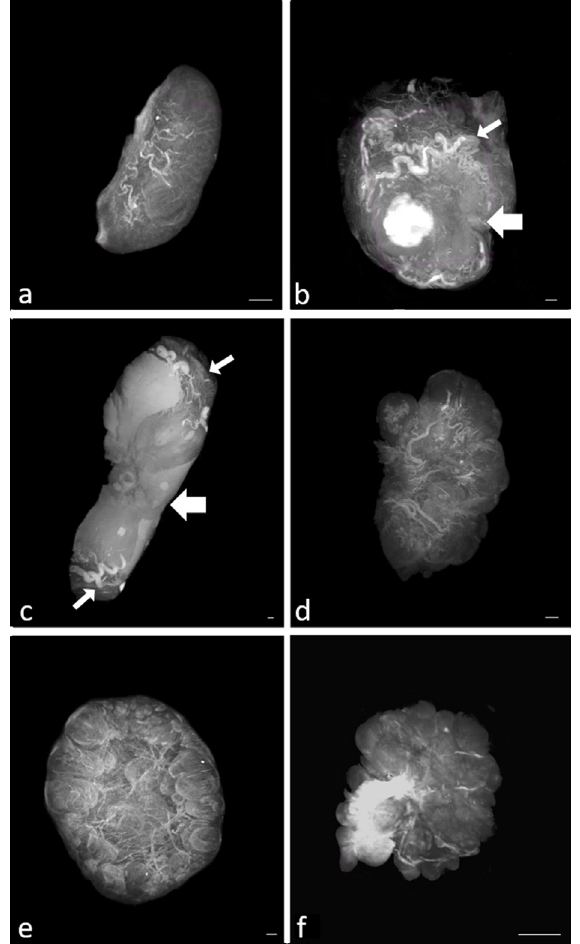
Figure 1- MicroCT images of the ovary with emphasis on blood vessels. Blood vessels are concentrated in the medullar region in the ovaries of queen ( a ), female donkey ( b ) and mare ( c ), while spread throughout the whole organ in sow ( d ), cow ( e ) and rat ( f ). Thin arrows: medullar region, thick arrows: cortex region. White areas reveal greater concentration of the contrast substance in b and f . Barr = 2.5